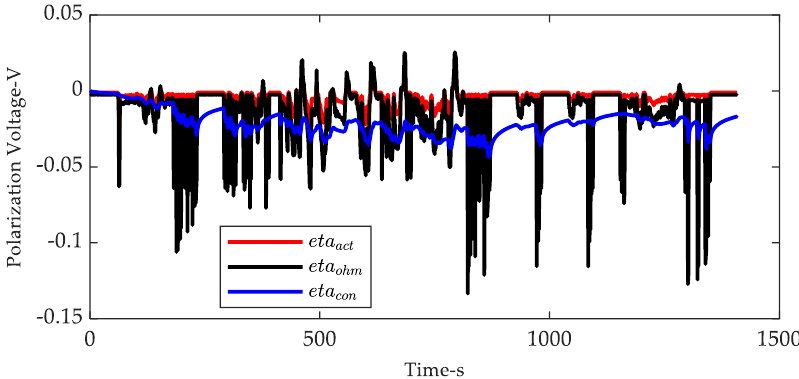
Figure 11. Quantitative characterization curves of three types of polarization voltage based on LDM.